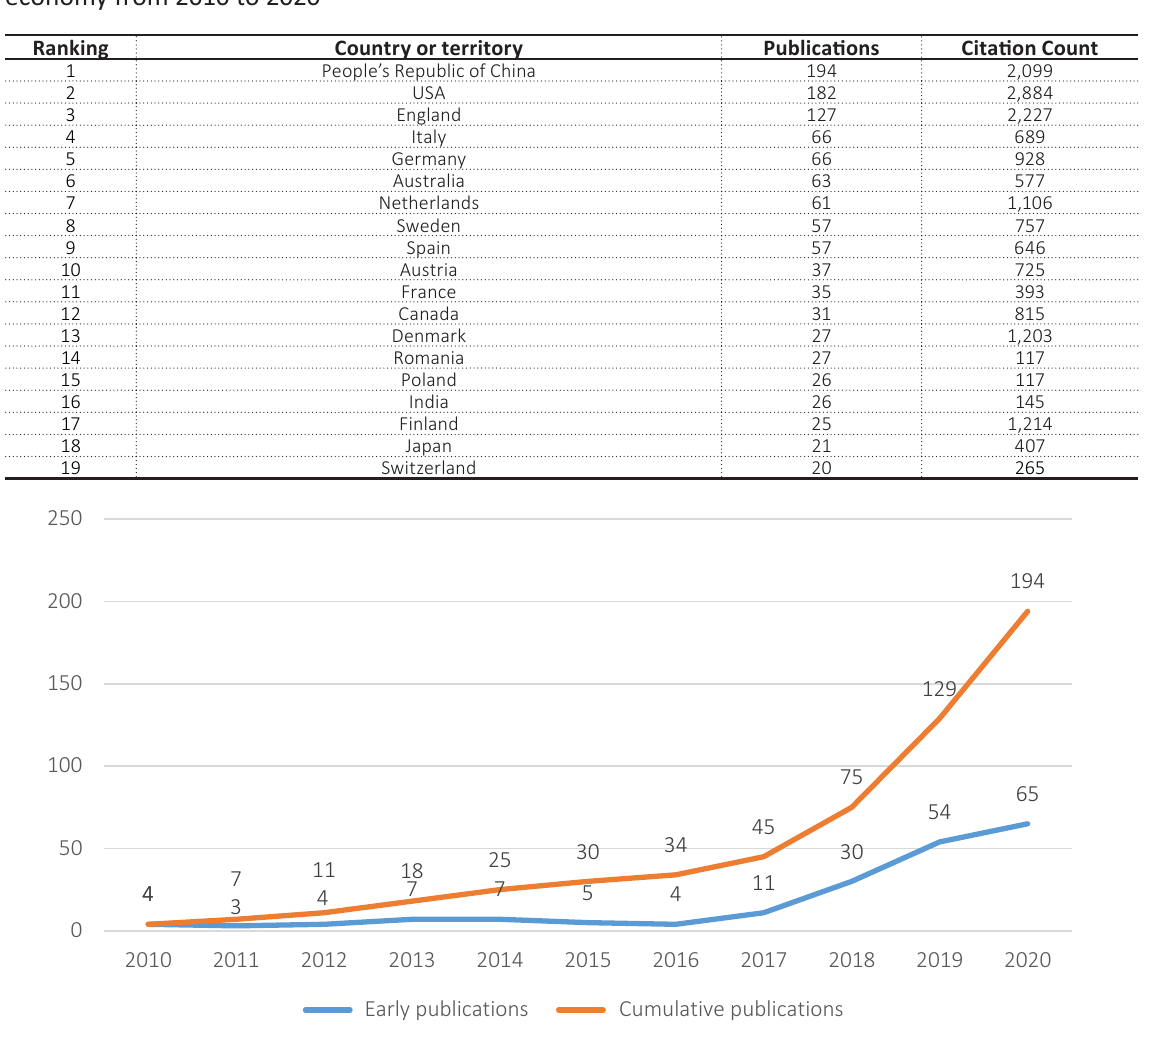
Table 2. Top 19 most contributing countries/regions on sustainable development in the